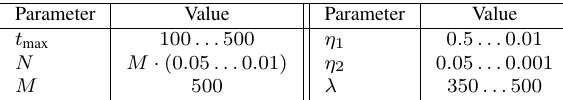
Table 1. The hyperparameter set for the GNG algorithm. Some